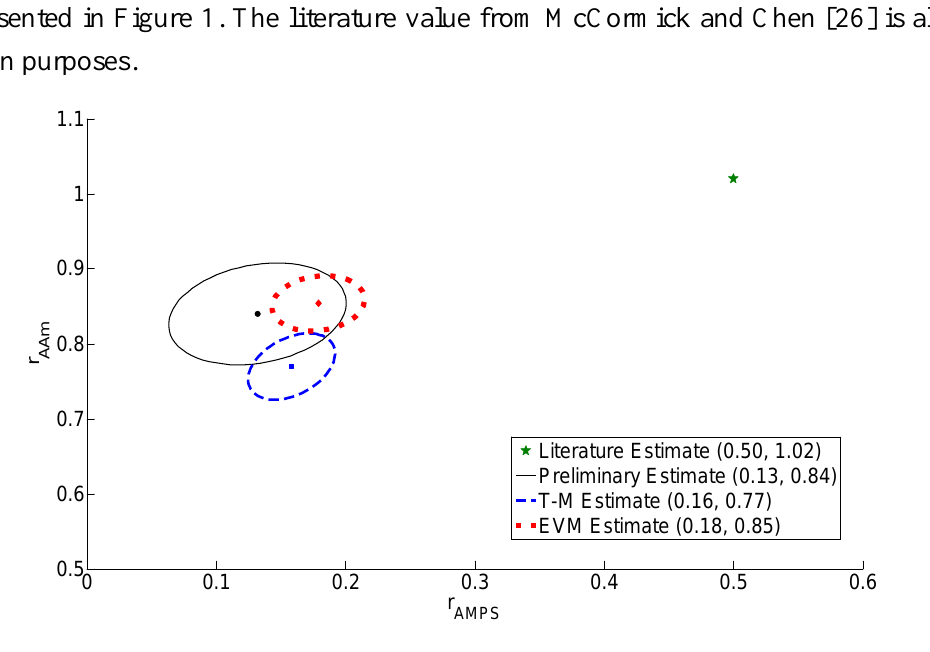
Figure 1. Reactivity ratio estimates for AMPS/AAm